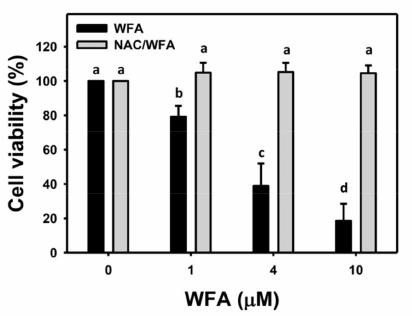
Figure 1. Cell viabilities of WFA in bladder cancer cells. The ROS inhibitor N -acetylcysteine (NAC) pretreated effect on the cell viability (24 h MTS assay) of bladder cancer cells (J82) following WFA incubation was also detected. Cells were pretreated with NAC (8 mM, 1 h) and post treated with WFA (0 to 10 µ M for 24 h), where the negative control for WFA (0 µ M) contained 0.1% DMSO. Data, mean ± SD ( n = 3). Columns showing non-overlapping lower-case letters indicate p < 0.05 for multiple comparisons. For example, WFA for 0, 1, 4, and 10 µ M treatments shows “a, b, c, d”, indicating significant differences among each other because they do not overlap with the same lower- case letters. Similarly, WFA 1 µ M and NAC/WFA 1 µ M showing “a” and “b” indicate significant differences among each